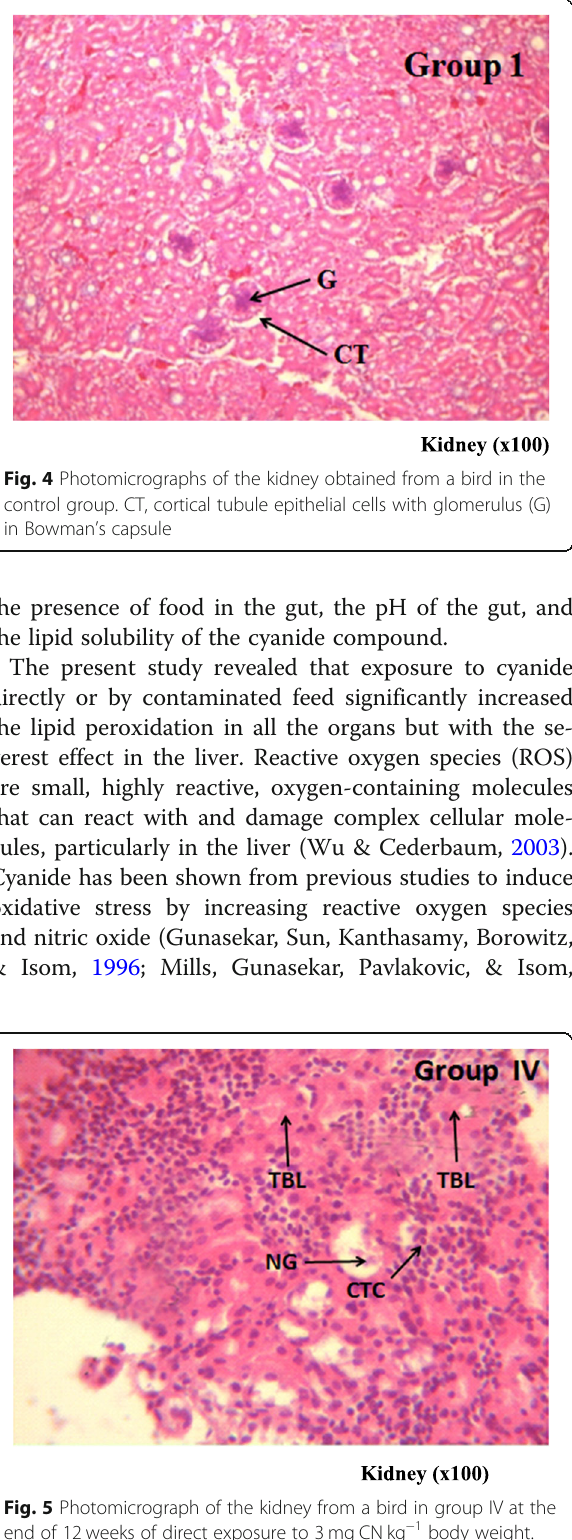
Fig. 3 Photomicrograph of the liver from a bird in group VII at the end of 12 weeks of direct exposure to 3 mg CN kg − 1 body weight. BDP, bile duct proliferation; CVC, central vein congestion; N, necrosis